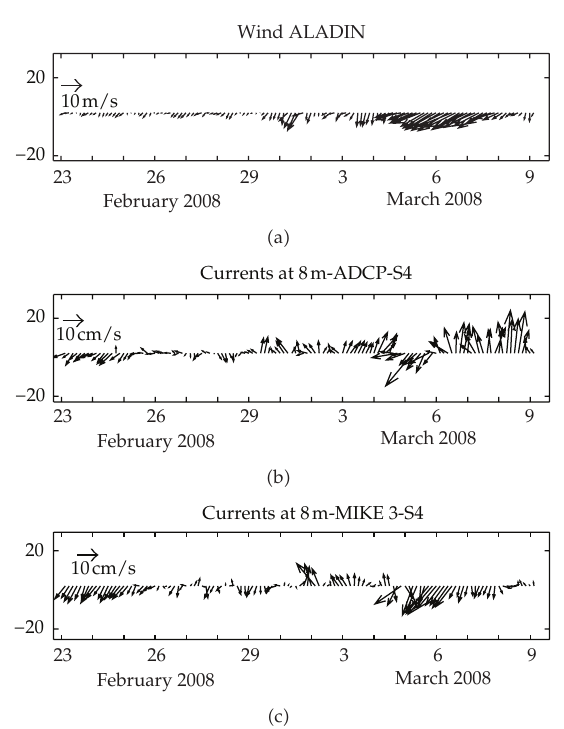
Figure 5: Hourly wind vector time series from the ALADIN model over the MIKE 3 nested domain (cid:4) a (cid:5) , hourly averaged surface current vectors measured at ADCP station S4 at 8 m depth (cid:4) b (cid:5) , and hourly averaged current vectors from the MIKE 3 model at the corresponding model cell (cid:4) c (cid:5) , during the winter period from 23rd of February to 9th of March